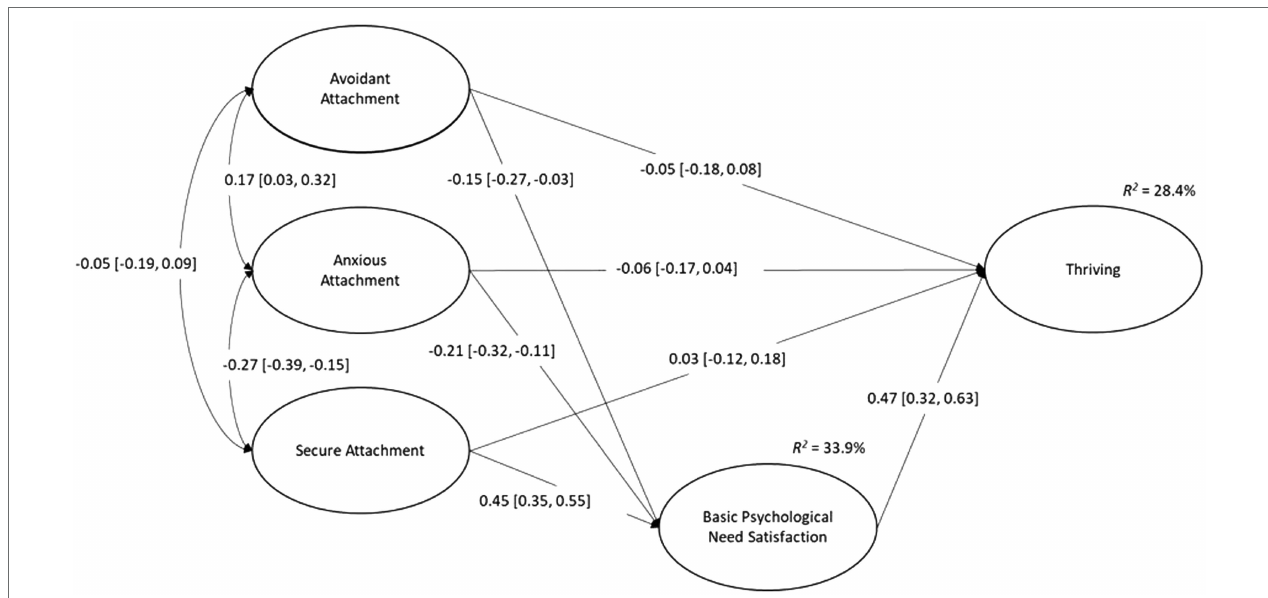
FIGURE 1 | Latent path model displaying the mediation model with attachment styles, basic psychological need satisfaction, and thriving. Standardized parameter estimates are displayed with the 95% confidence interval in